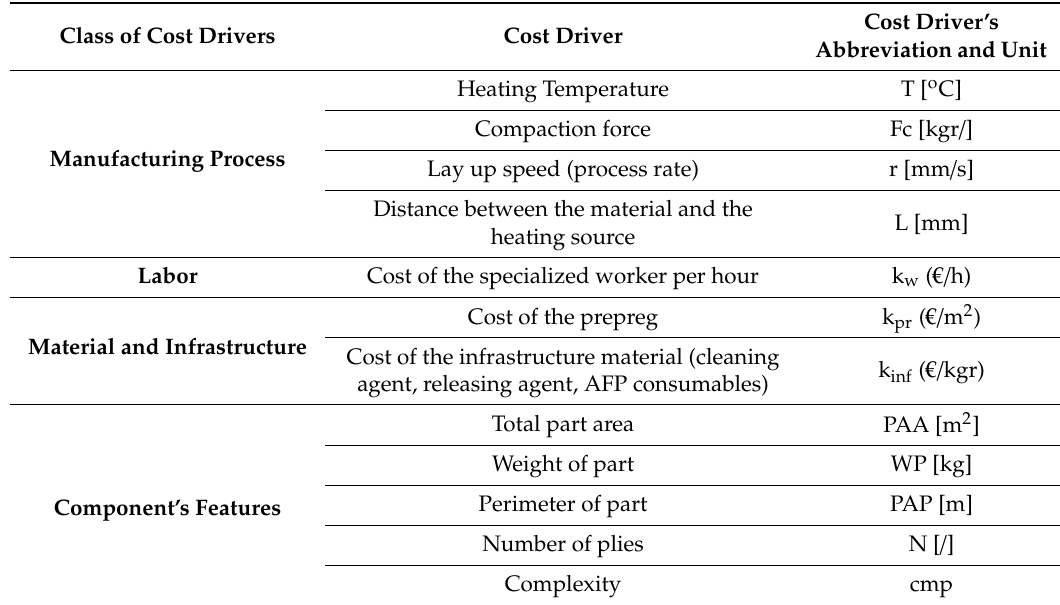
Table 5. Part, Process, Material and Infrastructure related Cost Drivers.